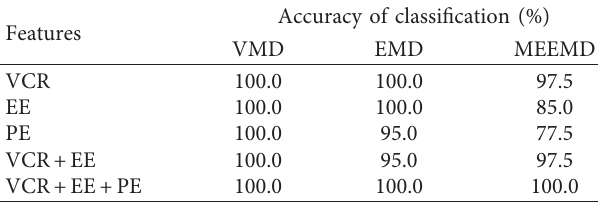
Table 2: The classification results with SVM (2hp).